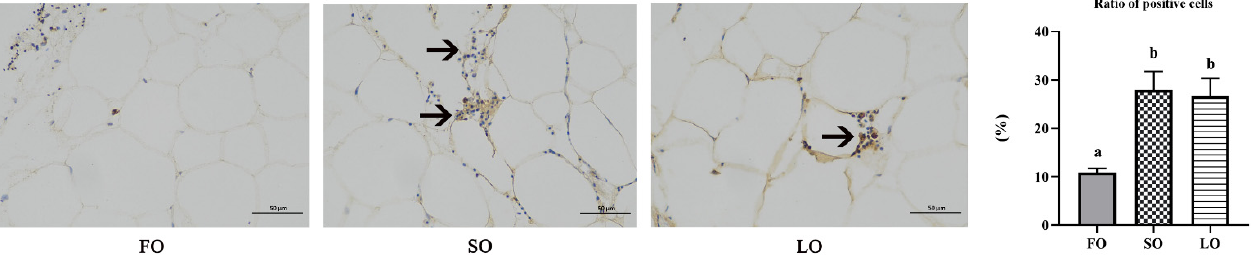
Figure 6. Immunohistochemical and the ratio of positive cells in adipose tissue of large yellow croaker fed SO and LO diets. Scale bars, 50 μ m. Three visual fields per slice were selected for calculation (n = 9). Results are presented as the means ± S.E.M. and were analyzed using Tukey’s test. Bars labeled with the same letters are not significantly different ( p > 0.05).